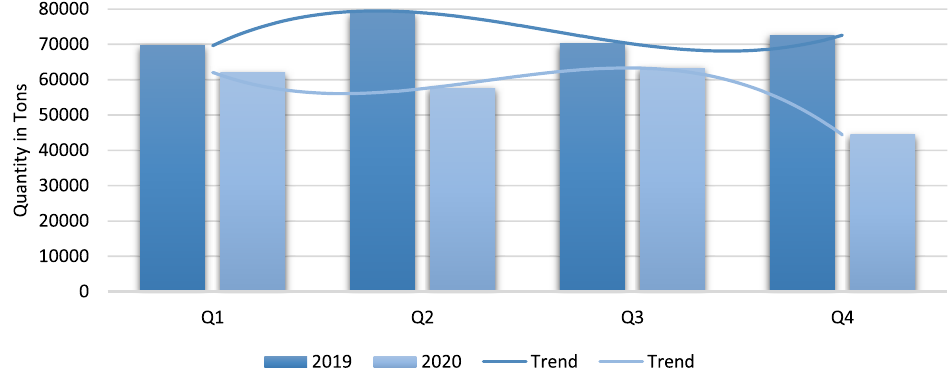
Fig. 7. Municipal solid waste comparison report almost 25% reduces as compare 2019 for four quarters (Ajman (cid:1) UAE) [15].